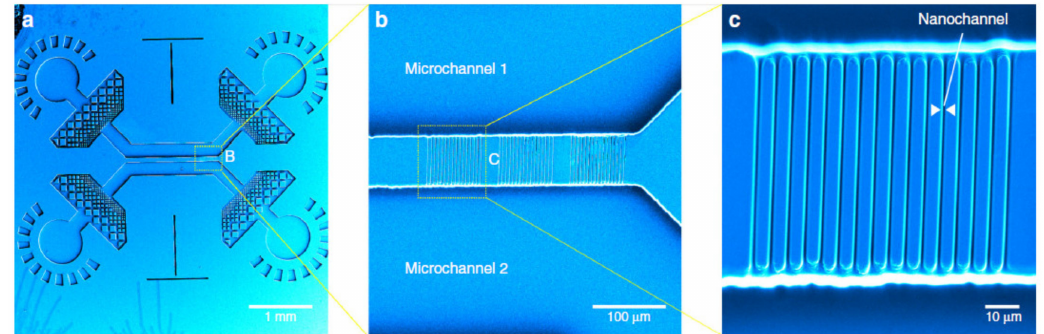
Figure 6. SEM of the nano-fluidic device fabricated by photolithography and MPL. ( a ) Device after PDMS molding. ( b ) 75 µ m nano-channels connecting the two micro-channels. ( c ) Magnified view showing the 420-nm wide nano-channels. Figure reproduced from Ref. [72] under CC BY